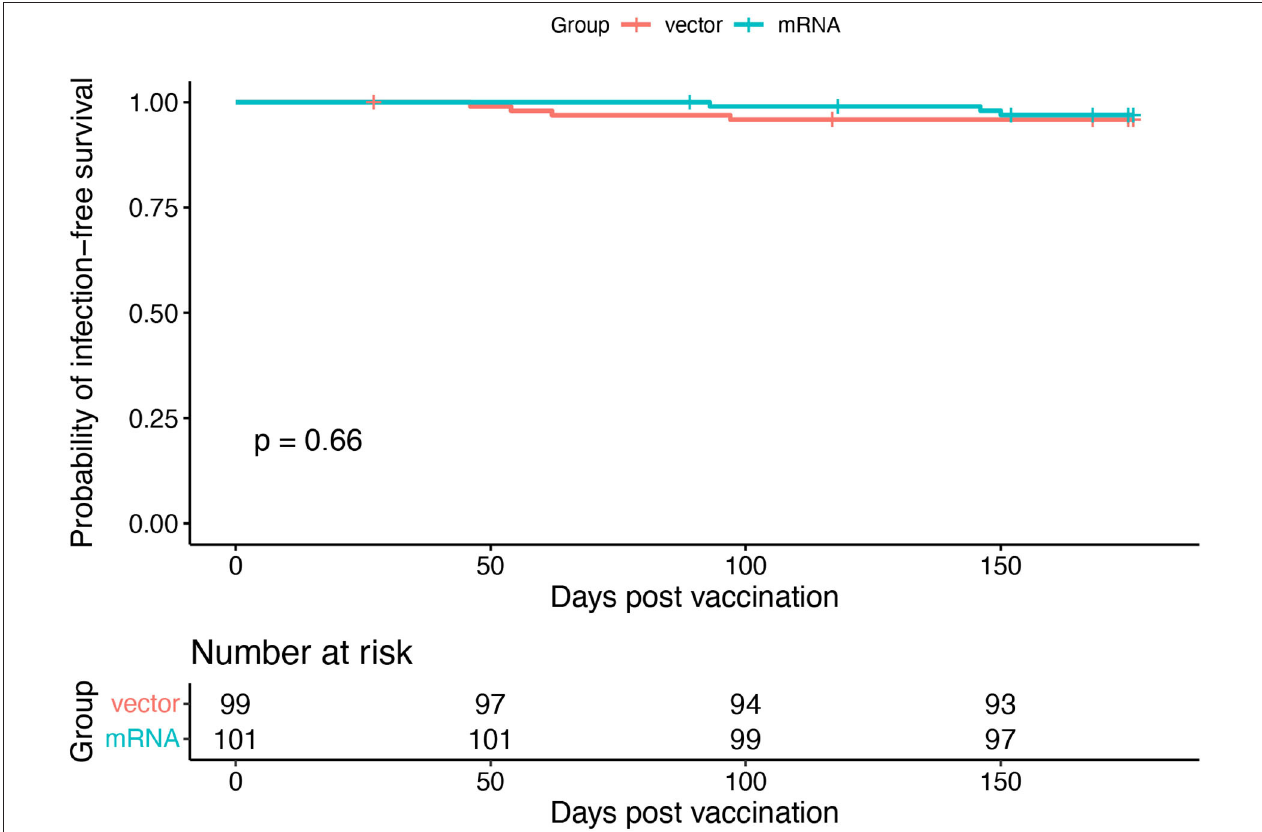
FIGURE 2 | Occurrence of COVID-19 infections. A Kaplan–Meier graph of COVID-19 infection-free duration after homologous and heterologous third SARS-CoV-2 vaccination throughout the observation period. In case of non-COVID-19-related death, the follow-up period was censored at the date of death.